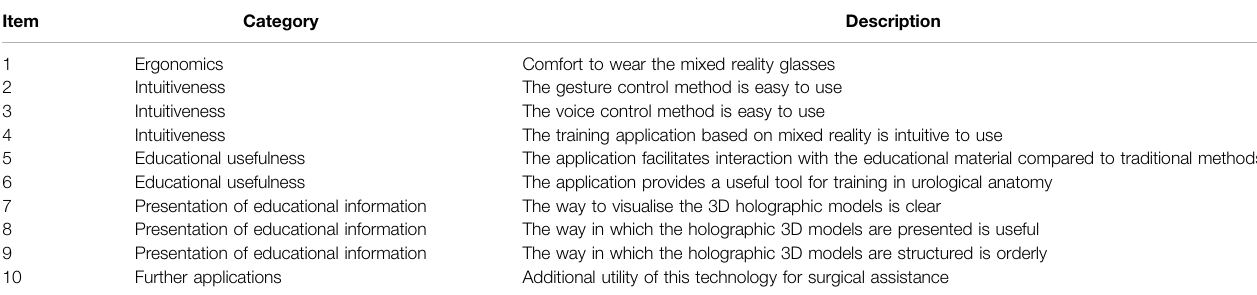
TABLE 1 | Set of subjective parameters regarding the surgeon ’ s experience with the urology training application developed for HoloLens.